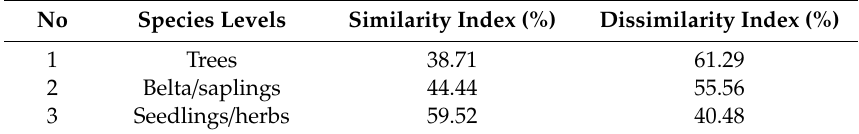
Table 4. Sorensen similarity index between discharge areas of pine forest in Watujali and